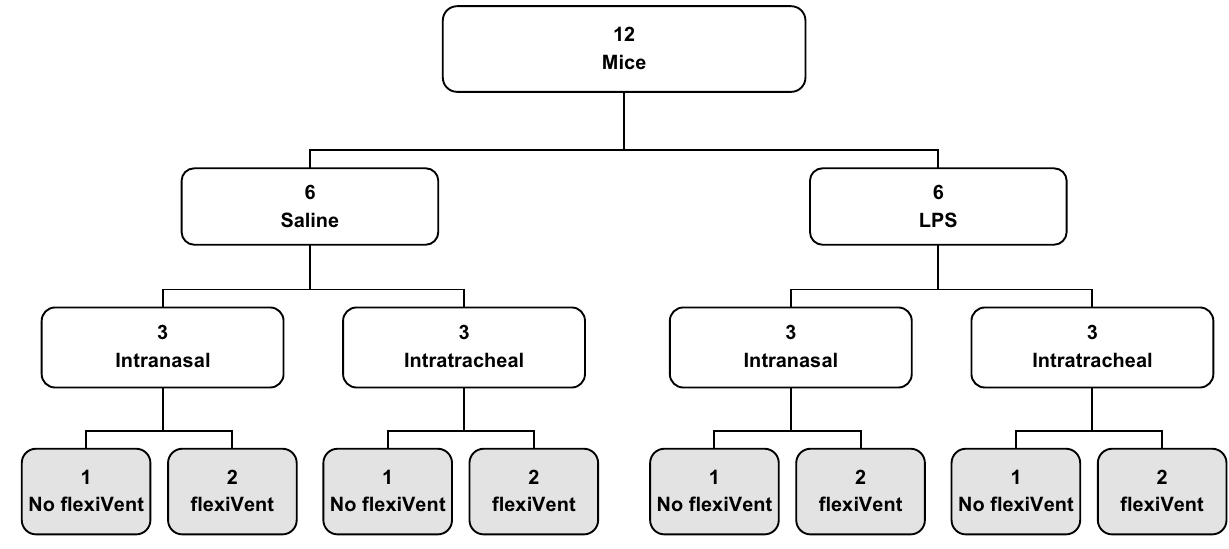
Figure 1. Schematic of the experimental protocol. On day 1, the mice were assigned to one of four experimental groups: 1- saline delivered intranasally; 2- saline delivered intratracheally; 3- LPS delivered intranasally; or 4- LPS delivered intratracheally. On day 2 (in gray), exactly 24 h after saline or LPS exposure, the mice were tested. Respiratory mechanics was assessed with the flexiVent on 2 mice in each group. The bronchoalveolar lavages, the lung wet-to-dry weight ratio, and the histology on lung slices were performed on all mice. The contractile assays with excised tracheas were performed on one mouse tested with the flexiVent and one mouse not tested with the flexiVent in each group. This protocol was repeated 6 times to reach the sample sizes shown in Table 1.